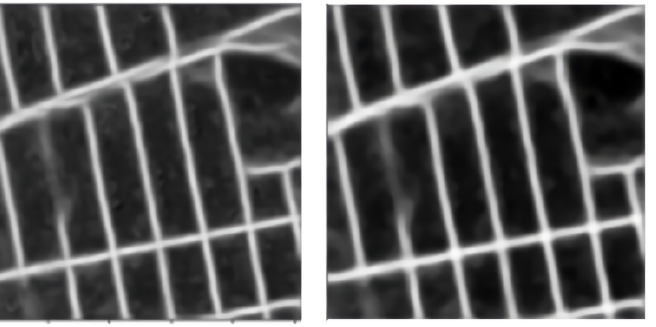
Figure 7. Median blurring operation. The left side is that before applying the filter and the right side is that after applying the filter.